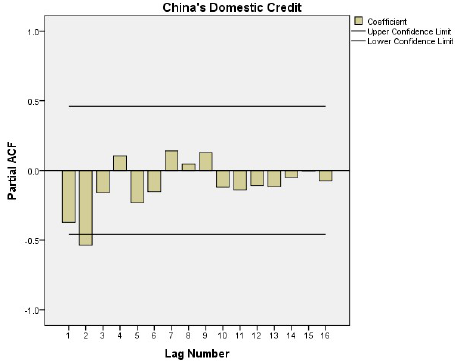
Fig. 8. China’s Series Autocorrelation Plots (The Box - Jenkins Method,